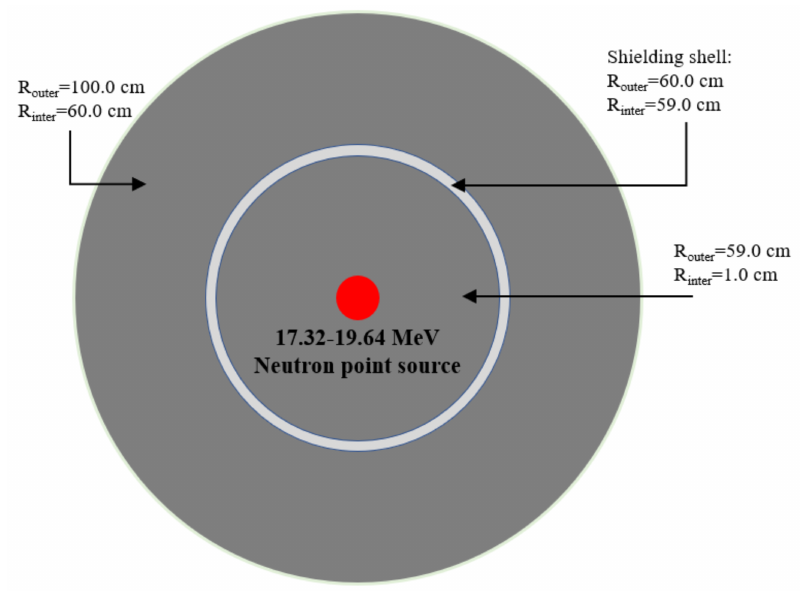
Figure 6. Geometric diagram of the self-designed one-dimensional sphere